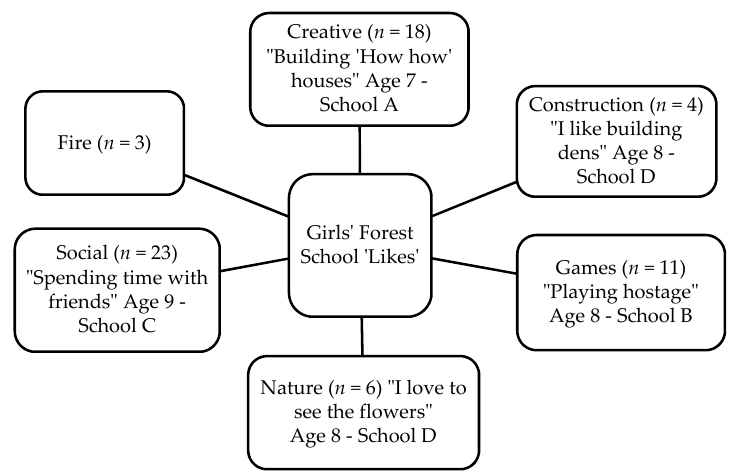
Figure 4. Pen profiles for boys’ answers to “What I like about Forest School is…?”.